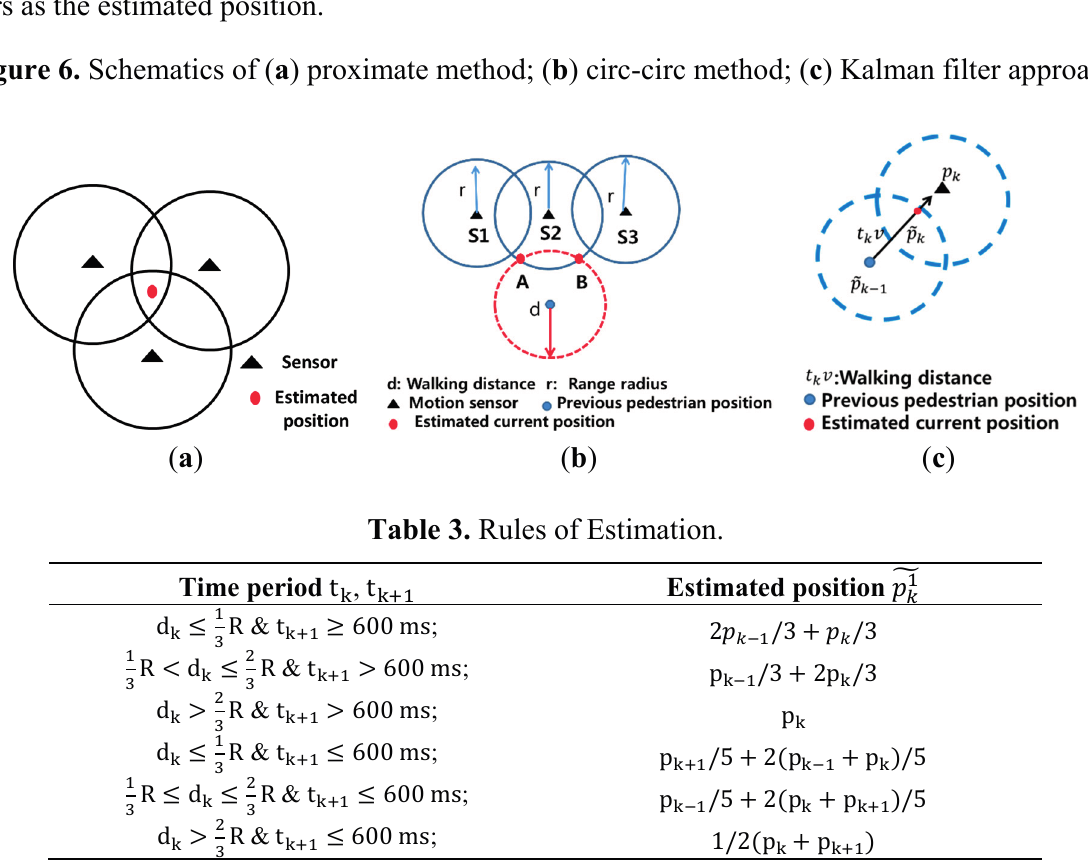
Table 3. Rules of